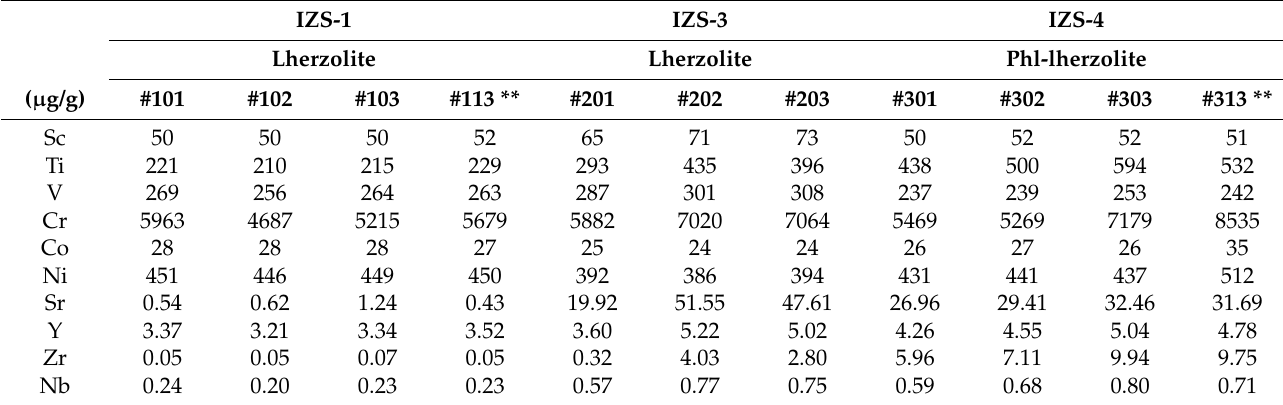
Table 3. Trace-element compositions of clinopyroxene in peridotite xenoliths from Bankawa, the SW Japan